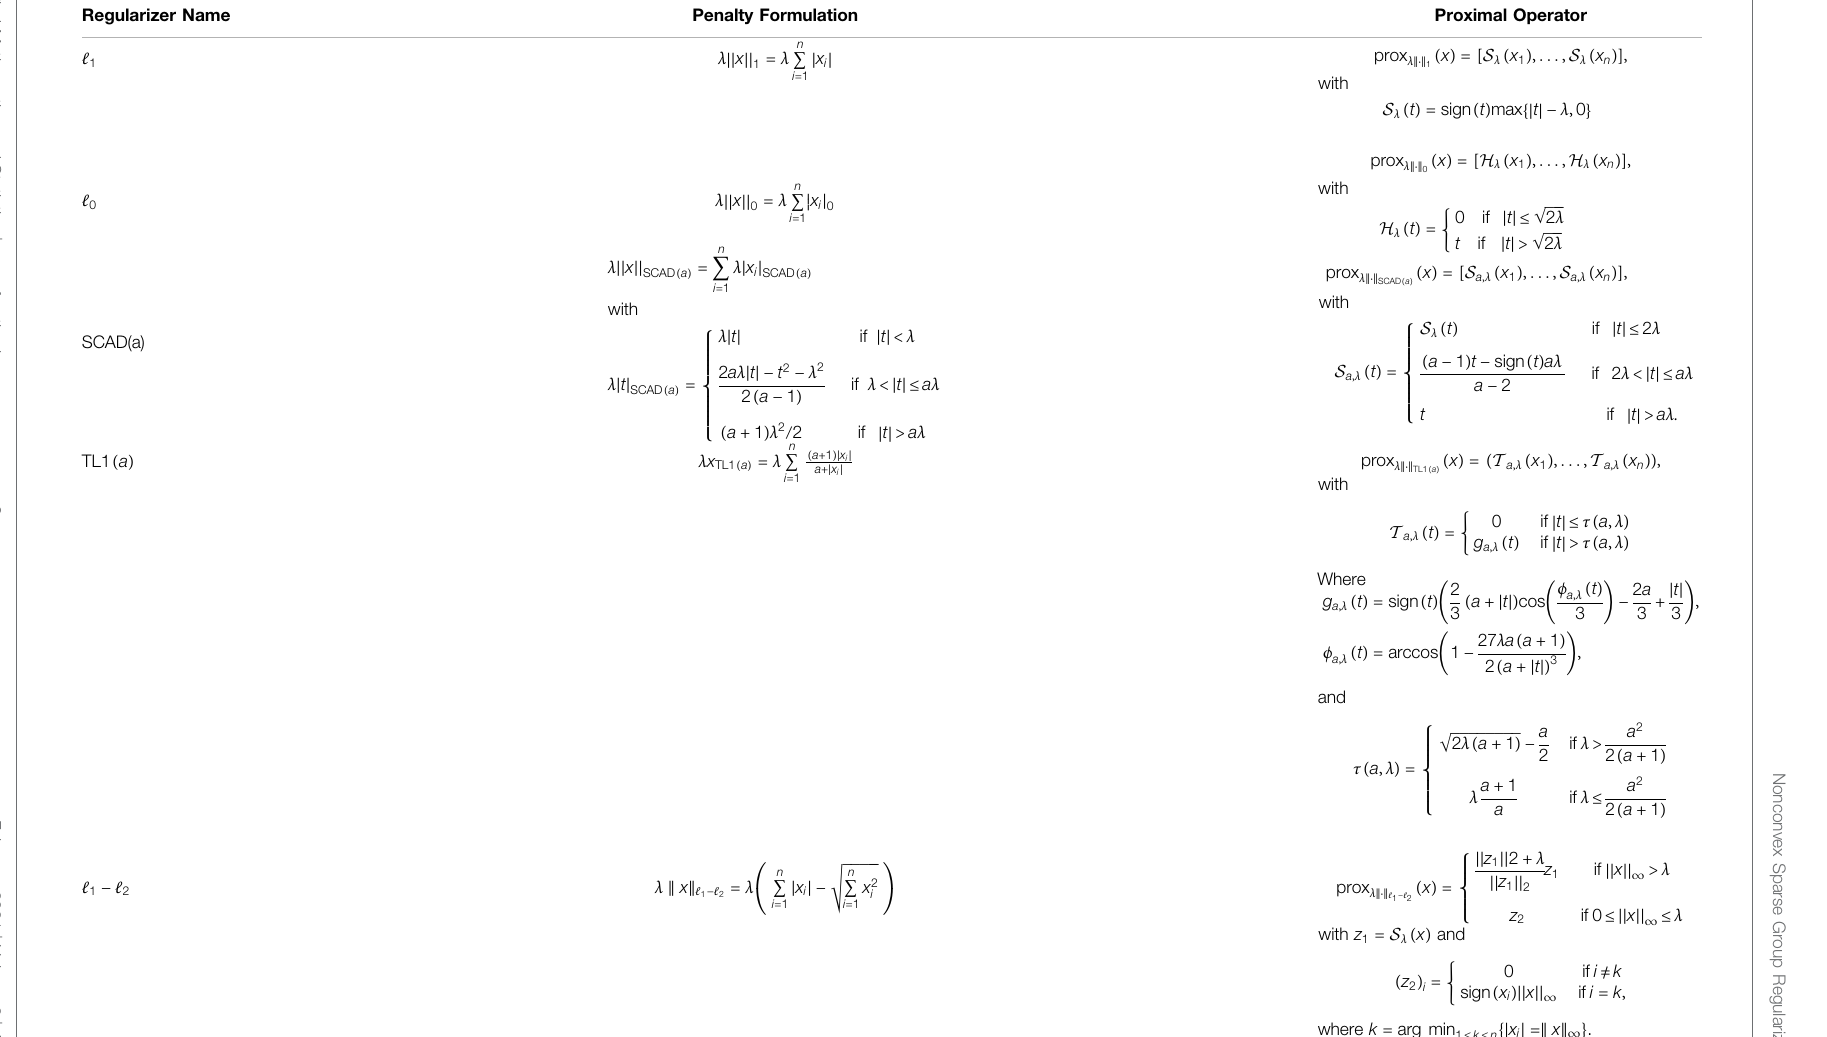
TABLE 1 | Regularization penalties and their corresponding proximal operators with λ >